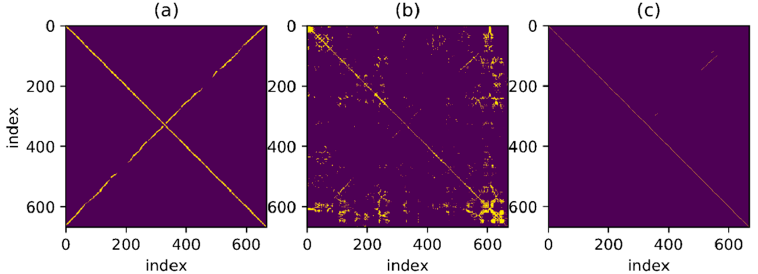
Figure 18. RANSAC-based matching result of Path D. ( a ) Matching relationship generated from the reference trajectory. ( b ) Results when MFD is higher than the threshold. ( c ) Selected matching points based RANSAC.